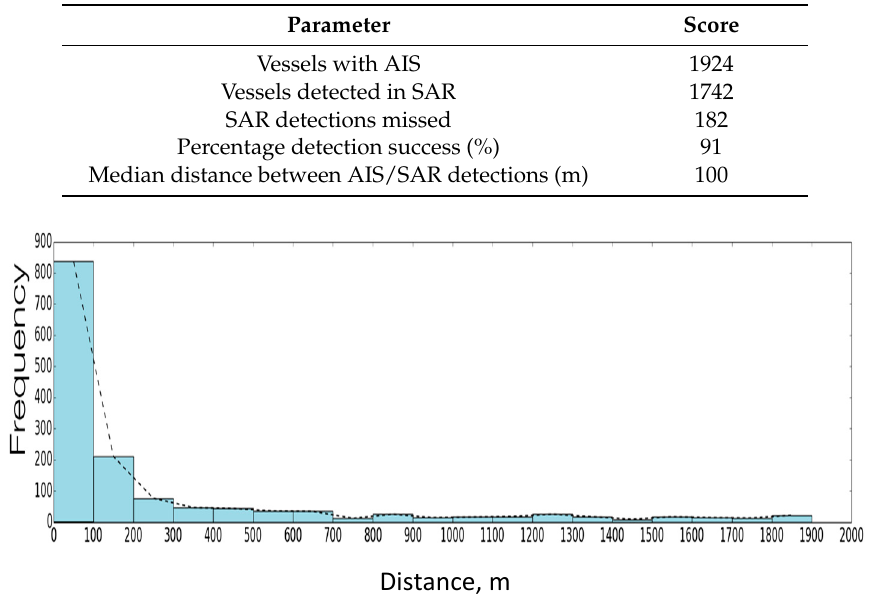
Figure 14. Distribution of distances between SAR–AIS vessel matches.